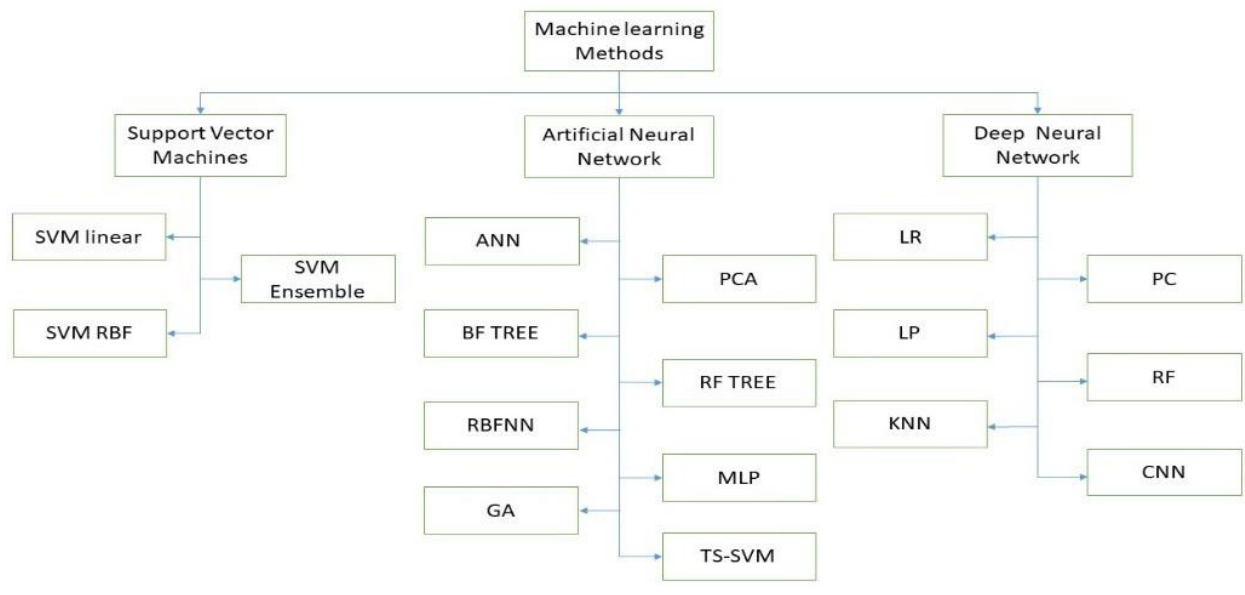
Figure 9. Classification methods based on machine learning.